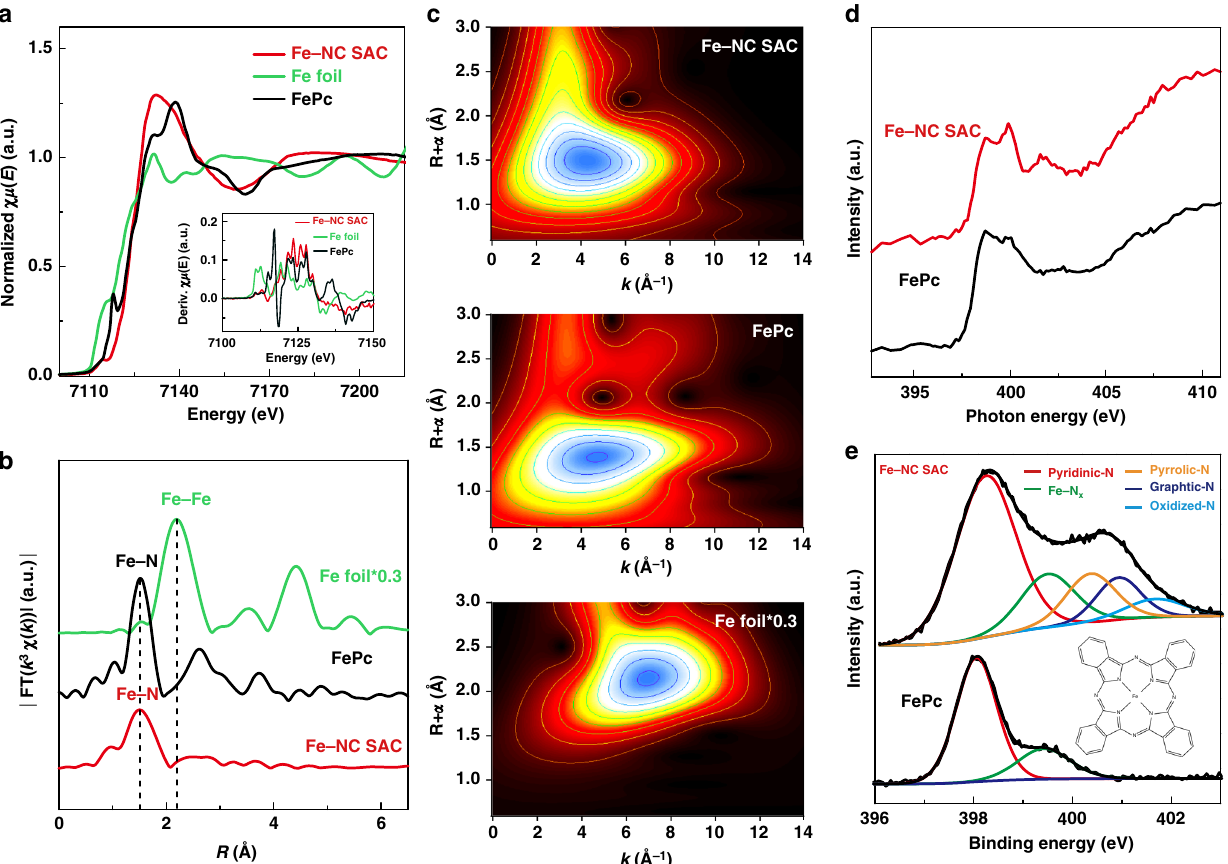
Fig. 3 Atomic structure analysis of Fe – NC SAC by XAFS and XPS. a Fe K-edge XANES spectra (inset: fi rst-derivative curves), b Fourier transform of Fe K-edge EXAFS spectra, and c , Wavelet transform of the k 3 -weighted EXAFS data of Fe – NC SAC and reference samples (FePc and Fe foil). d N K -edge NEXAFS spectra and e , deconvoluted N 1 s XPS spectra of Fe – NC SAC and reference